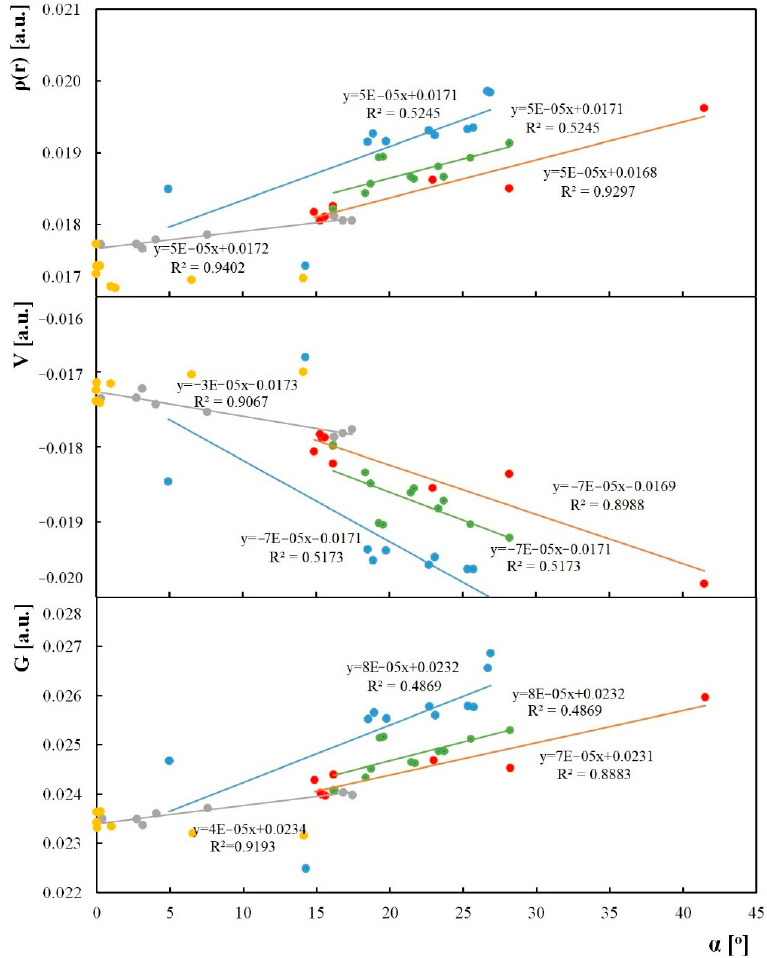
Figure 1. Correlations of quantum theory of atoms in molecules (QTAIM) parameters at the ring- critical point of the central ring. A-electron density, b-kinetic-energy density, c-potential-energy density, where blue-structures from the Cambridge Structural Database (CSD); red-anthrones with a substituent in the central ring, grey anthrones with substituent NO 2 and NH 2 , yellow-anthraquinones with substituent NO 2 and NH 2 , and green-optimized experimental structures from CSD.